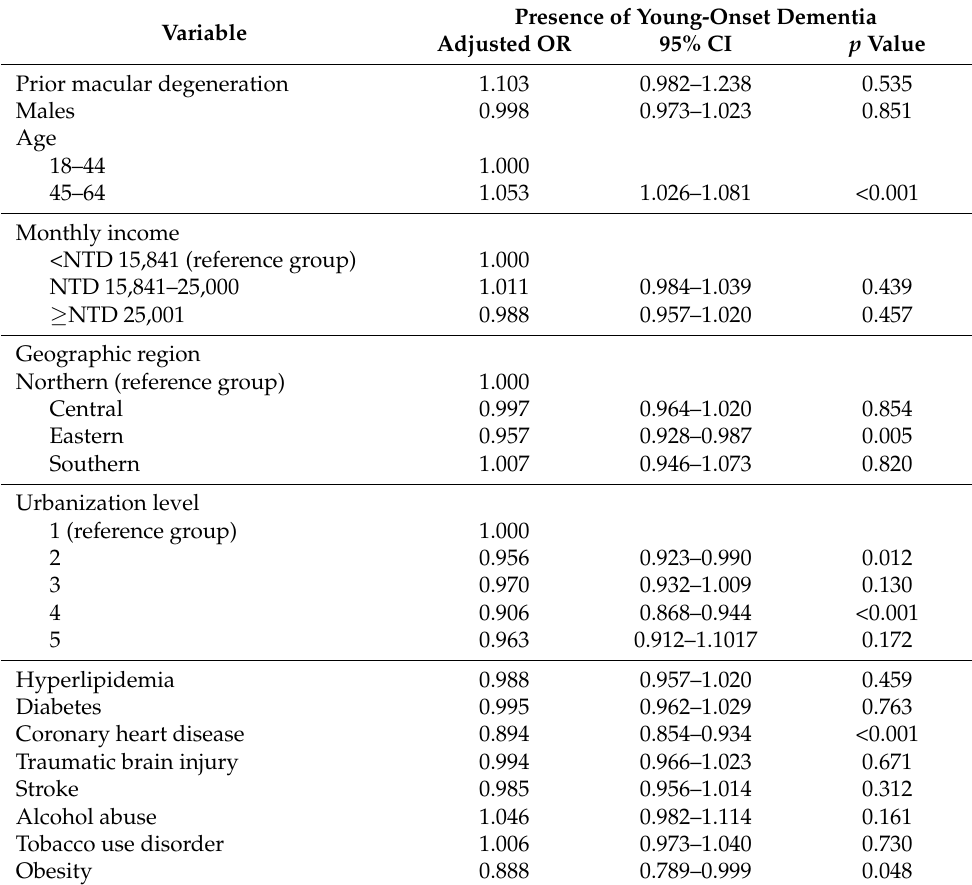
Table 3. Covariate-adjusted odds of prior age-related macular degeneration (OR and 95% confidence interval, CIs) among patients with young-onset dementia vs. controls ( n =